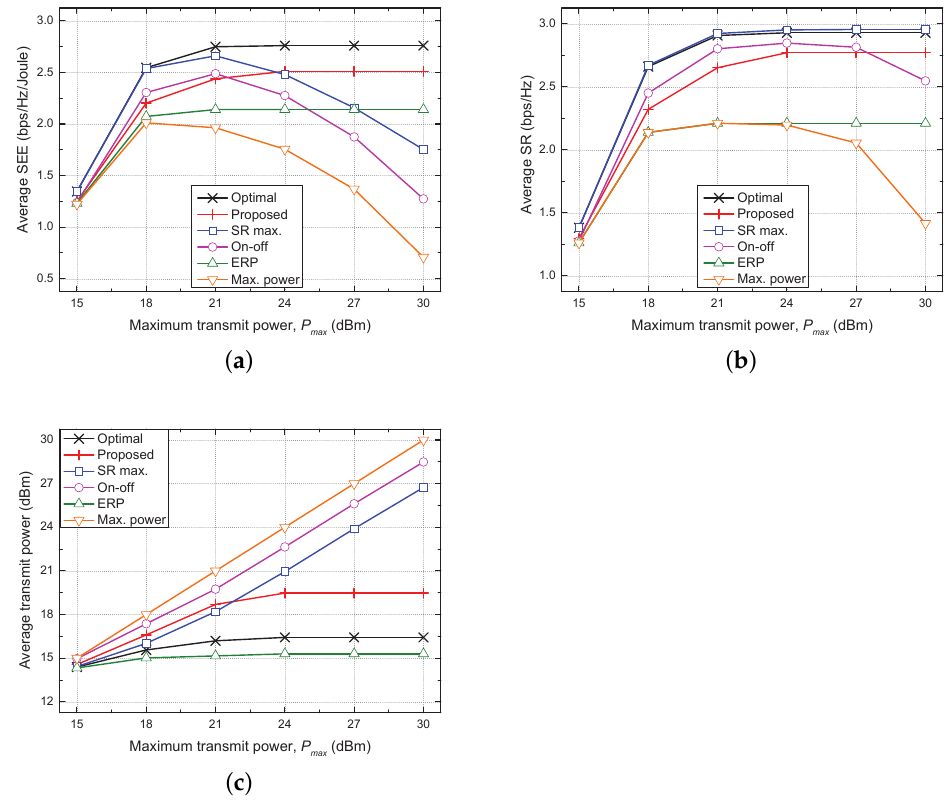
Figure 2. Comparison of performances of five considered schemes as a function of maximum transmit power ( P max ). ( a ) Average SEE vs. P max . ( b ) Average SR vs. P max . ( c ) Average transmit power vs. P max .